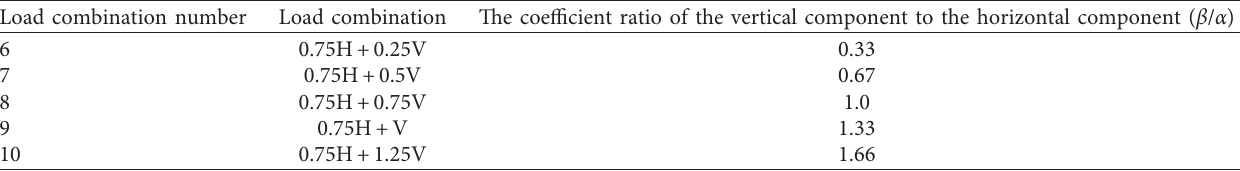
Table 10: Load combinations, including a horizontal component having coefficient 0.75 and a vertical component with a variable